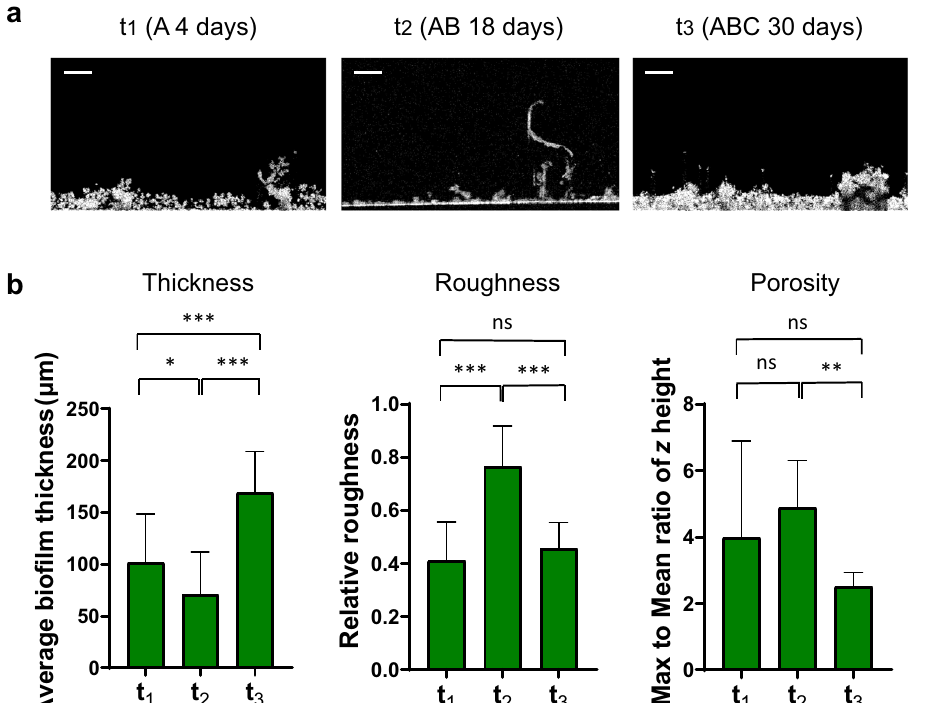
Fig. 3 Changes of the periphyton physical structure during its establishment. Shown are representative OCT images obtained over 30 days of periphyton growth at time points t 1 (A 4 days), t 2 (AB 18 days), and t 3 (ABC 30 days) ( a ). White pixel: Biomass accumulation, black pixel: absent/low biomass accumulation. Scale bar: 200 µm. Mean thickness, surface topology (relative roughness), and internal porosity (mean to max ratio of z , where z is the height of the bio fi lm) were determined from 20 to 30 images and 5 biological replicates per time point ( b ). Error bars represent standard deviations. * P < 0.05, ** P < 0.005 *** P < 0.0001, post hoc Tukey